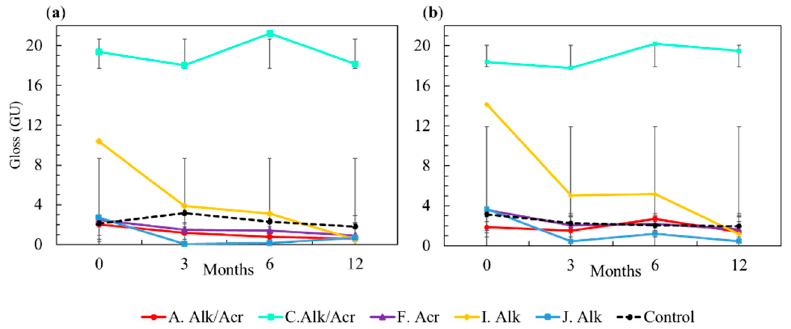
Figure 5. Gloss variation (GU) of tested coatings exposed to natural weathering in ( a ) Mississippi and ( b ) Wisconsin.